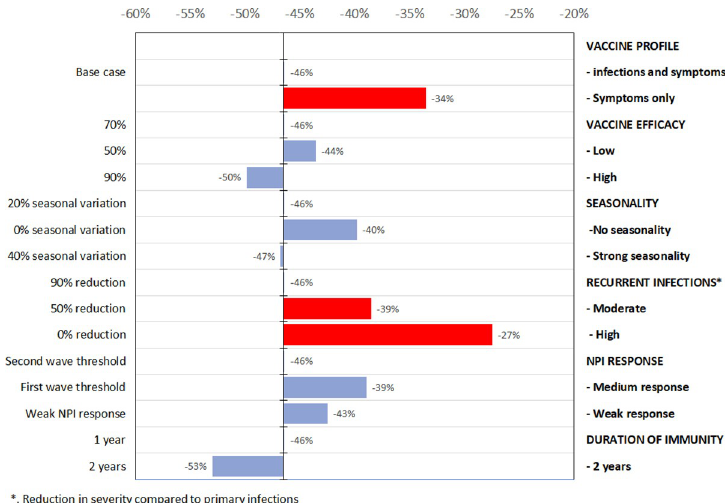
Fig 4. Tornado diagram on the impact of a variation of vaccine and disease characteristics on the reduction in hospitalization in 2021–2022 associated to vaccination (relaxed strong supply and uptake constraints scenario). All outcomes presented corresponds to univariate sensitivity analysis of the reference case for key disease and vaccine characteristics. The figure shows the change in number of hospitalizations (as %) for the 2021–2022 period compared to no vaccination counterfactual for different vaccine and disease characteristics. The red bars correspond to factor with the largest impact, figures next to the bars to the impact on COVID-19 hospitalizations compared to no vaccination and bars are oriented right or left depending of if the figure is smaller or higher than base case (first row).